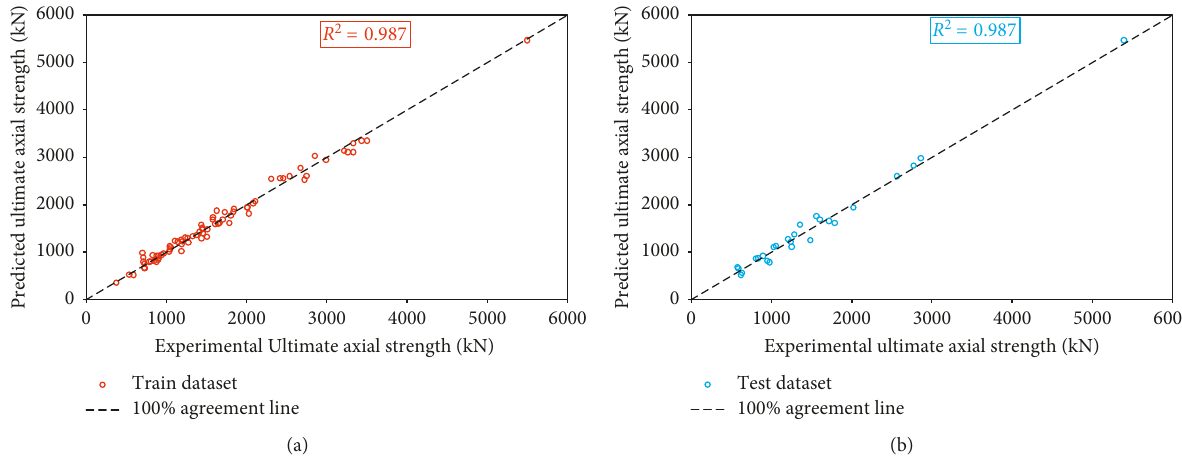
Figure 4: Ultimate axial strength prediction performance of the proposed model. (a) Train dataset. (b) Test